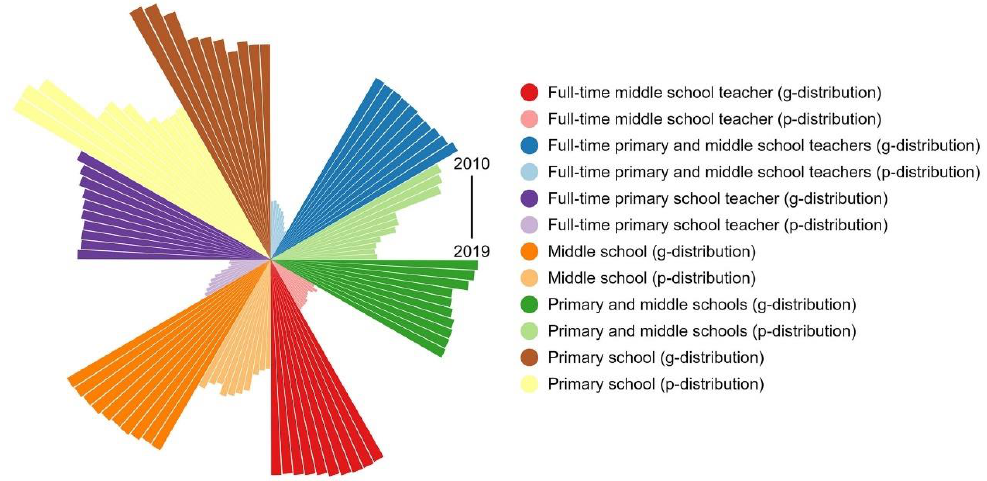
Figure 7. ID from 2010 to 2019. P-distribution represents population distribution; g-distribution represents geographic distribution; time increases in the clockwise direction.